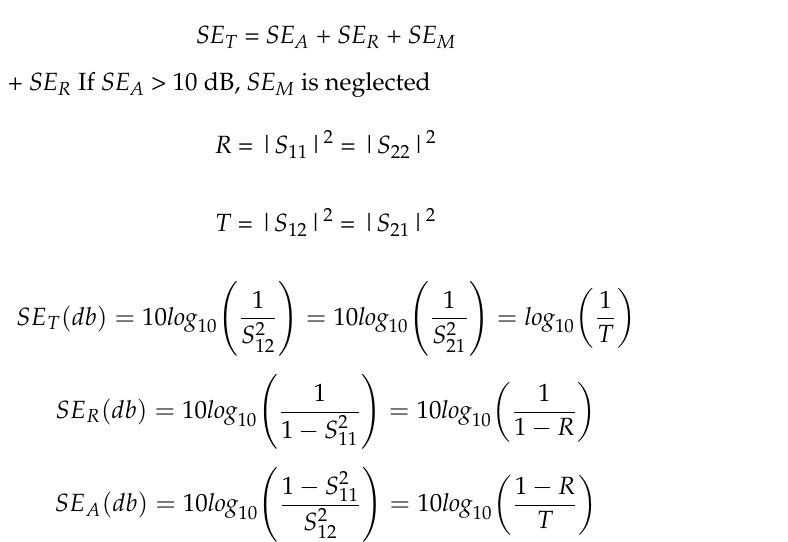
Figure 12. Network-analyzer experimental setup to measure S-parameter.